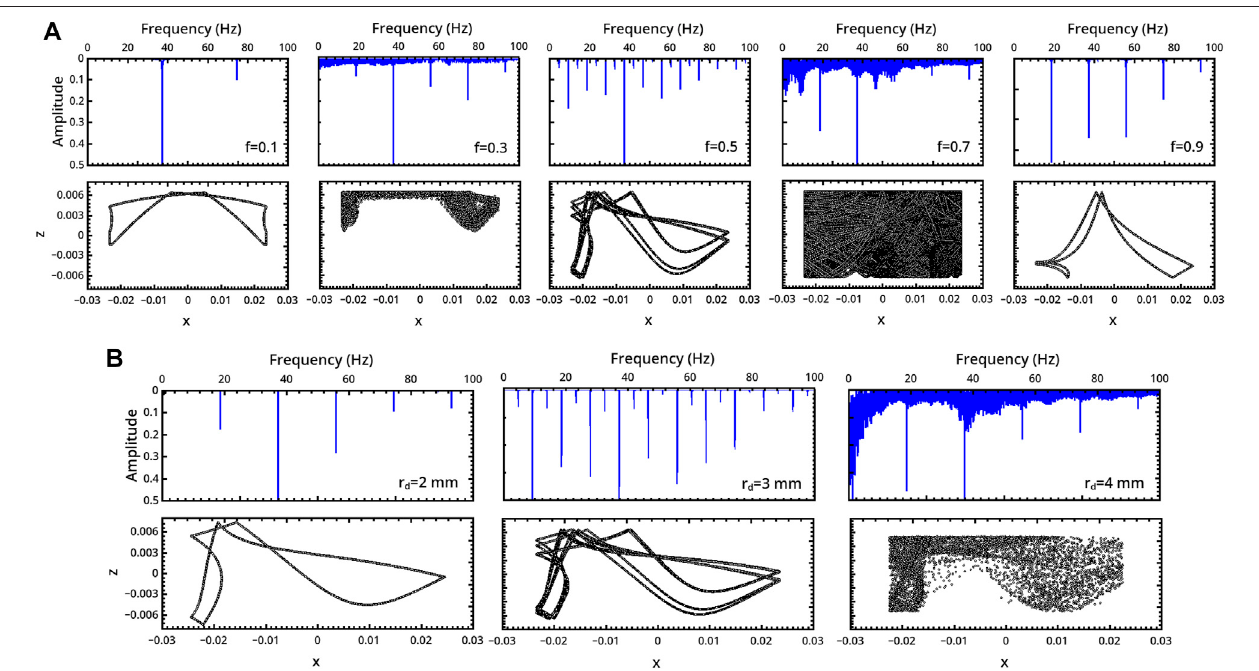
FIGURE 3| Characterization of the milling body dynamicsin a fl at-base geometry as afunction of (A) the restitution coef fi cient f ( r d = 3 mm) and (B) the milling disc radius r d ( f = 0.5). For each regime, we report the trajectory (bottom) and the FFT of the related series describing the vertical displacement of the milling disc intime (top).